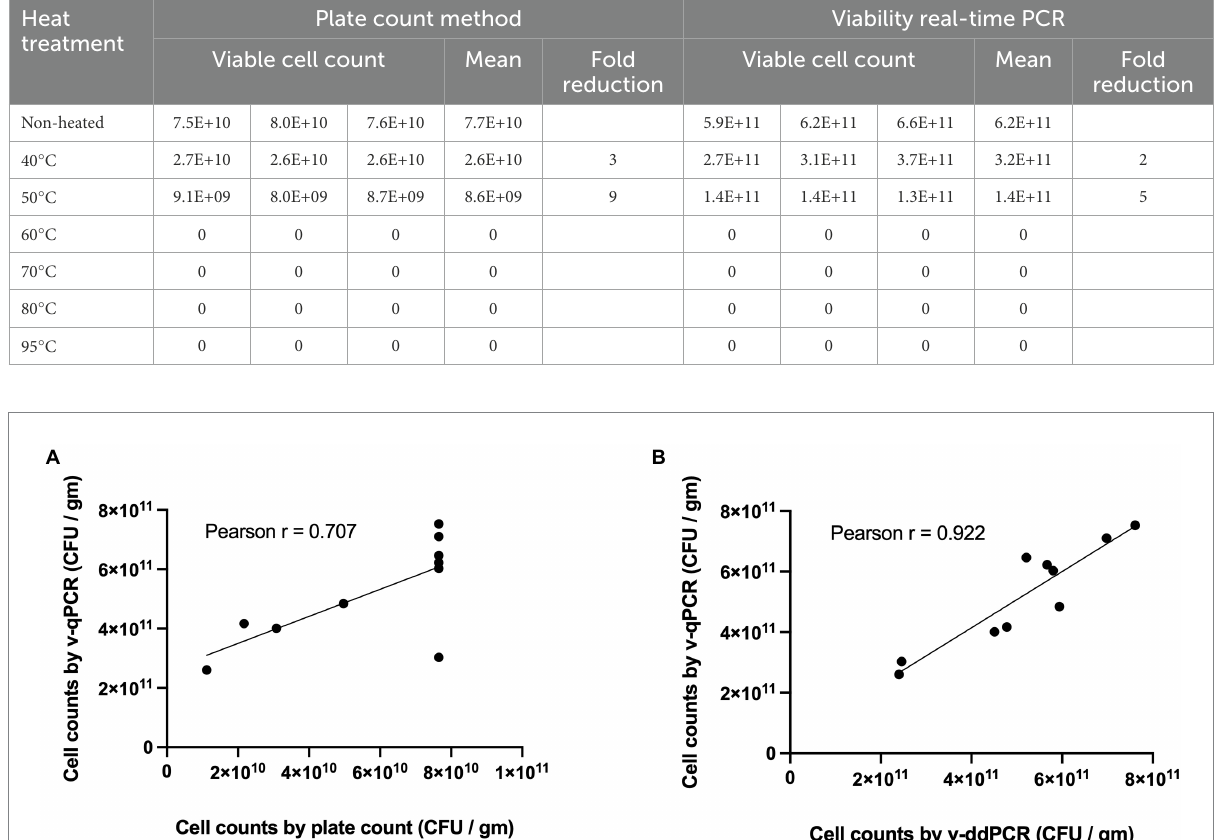
TABLE 3 Assessing the effect of heat treatments on viable counts determined using L. paracasei 8700:2 viability real-time PCR and plate count methods.